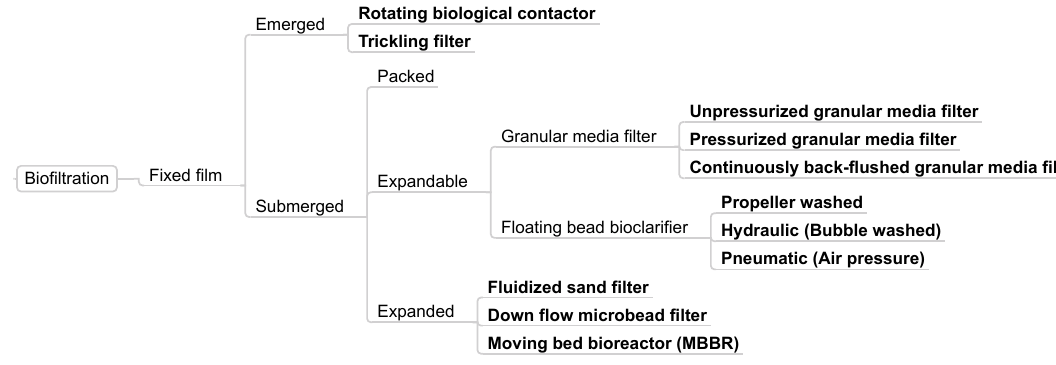
Figure 7. Partial taxonomy: